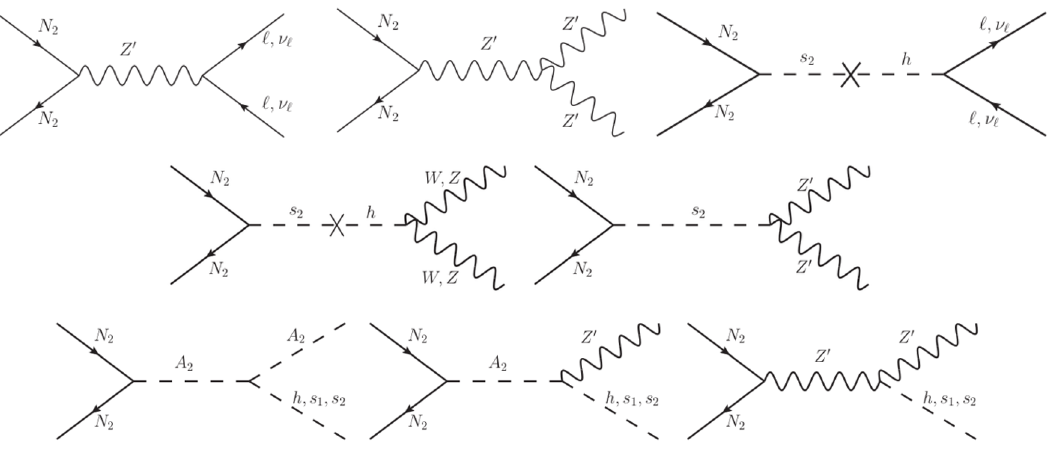
Figure 7 . The diagrams giving leading contributions to the relic